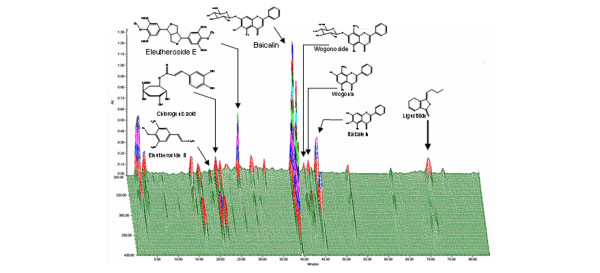
Standardization of the root extracts (high-performance liquid chromatography (HPLC) chromatogram). Compounds were detected with a photodiode array. X-axis, retention time; Y-axis, wavelength; and Z-axis, absorbance unit. The analytic conditions were as follows: column, C18 Φ 4 × 250 mm; mobile phase, 1% phosphoric acid (H3PO4; solvent A) and acetonitrile (CH3CN; solvent B); flow rate, 1 ml/min; and eluting gradient, 5% to 50% of solvent B in A (during minutes 1–60), followed by standing 70% of solvent B in A (during minutes 61–85).